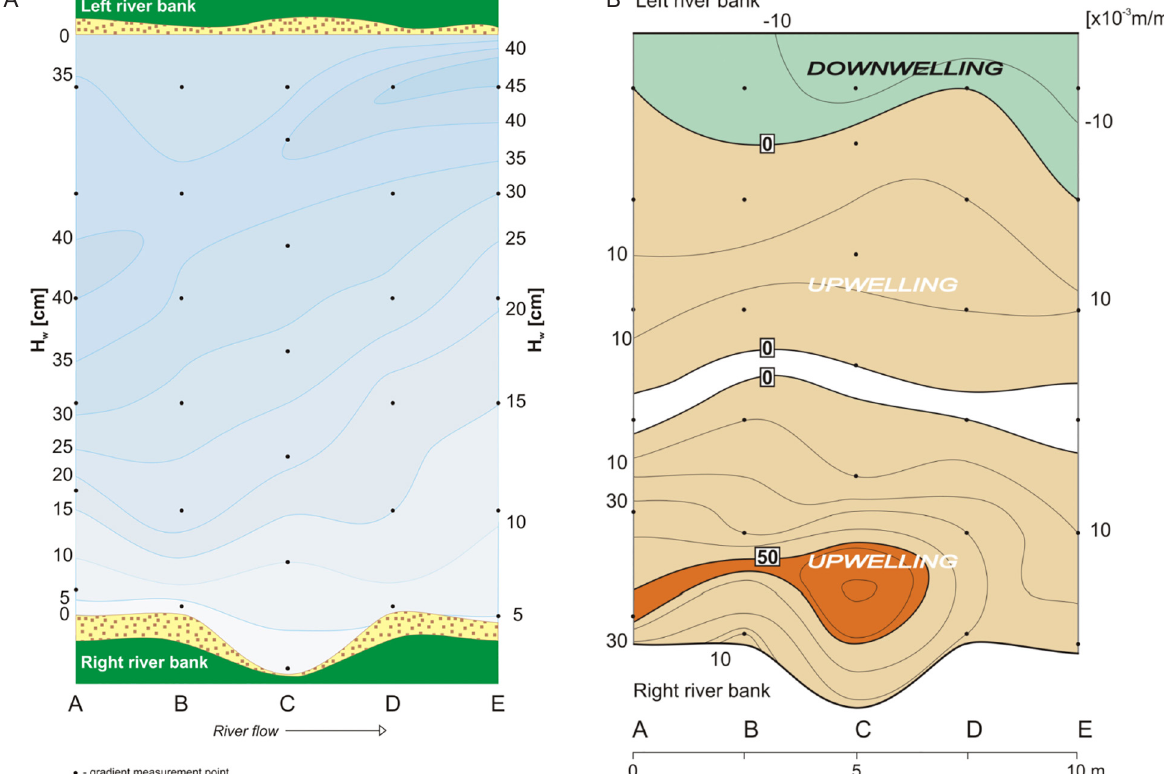
Fig. 9. Hydraulic gradient changeability in the river bottom during low water stage. A – Spatial distribution of water depth, B – Spatial distribution of hydraulic gradient.